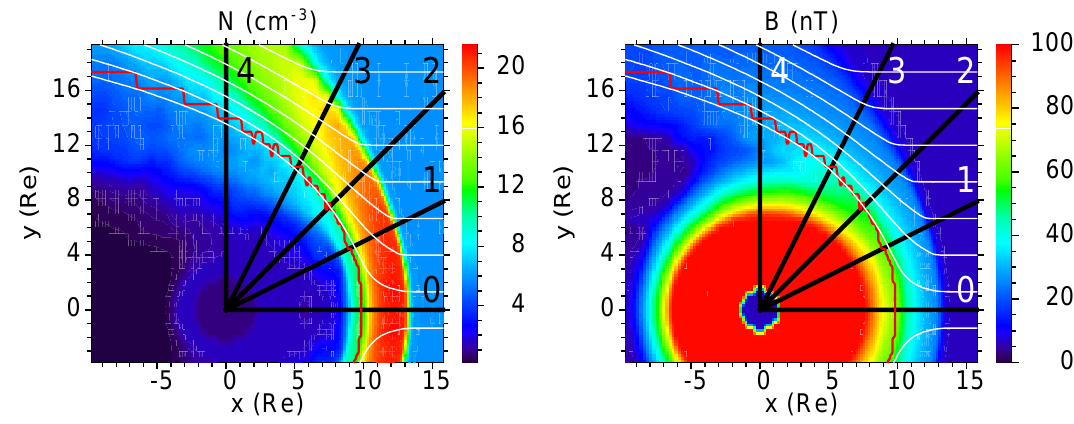
Fig. 2. The plasma density and the magnetic field magnitude in the z =0 plane. The open-closed magnetic field boundary is shown as a red zigzag curve and streamlines are shown as white smooth curves in each of the panels. We draw several radially outward straight lines from the center of the Earth. The plasma and field values along these radial lines are shown in Fig. 4.